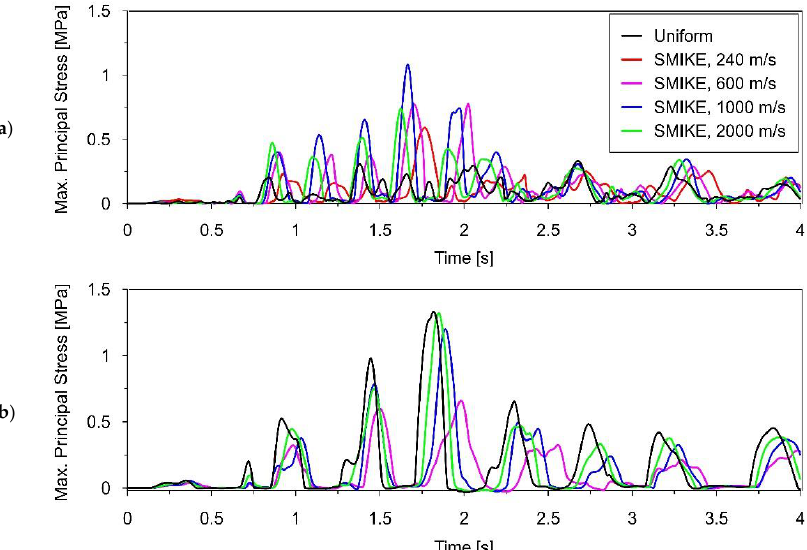
Figure 18. Time-stress histories obtained for the SMIKE model with the wave velocities: 240 m/s (red line), 600 m/s (violet line), 1000 m/s (blue line), 2000 m/s (green line), and for the uniform excitation (black line) at representative points: ( a ) S2 (in the middle of the second span), ( b ) L3 (in the middle of the third span).